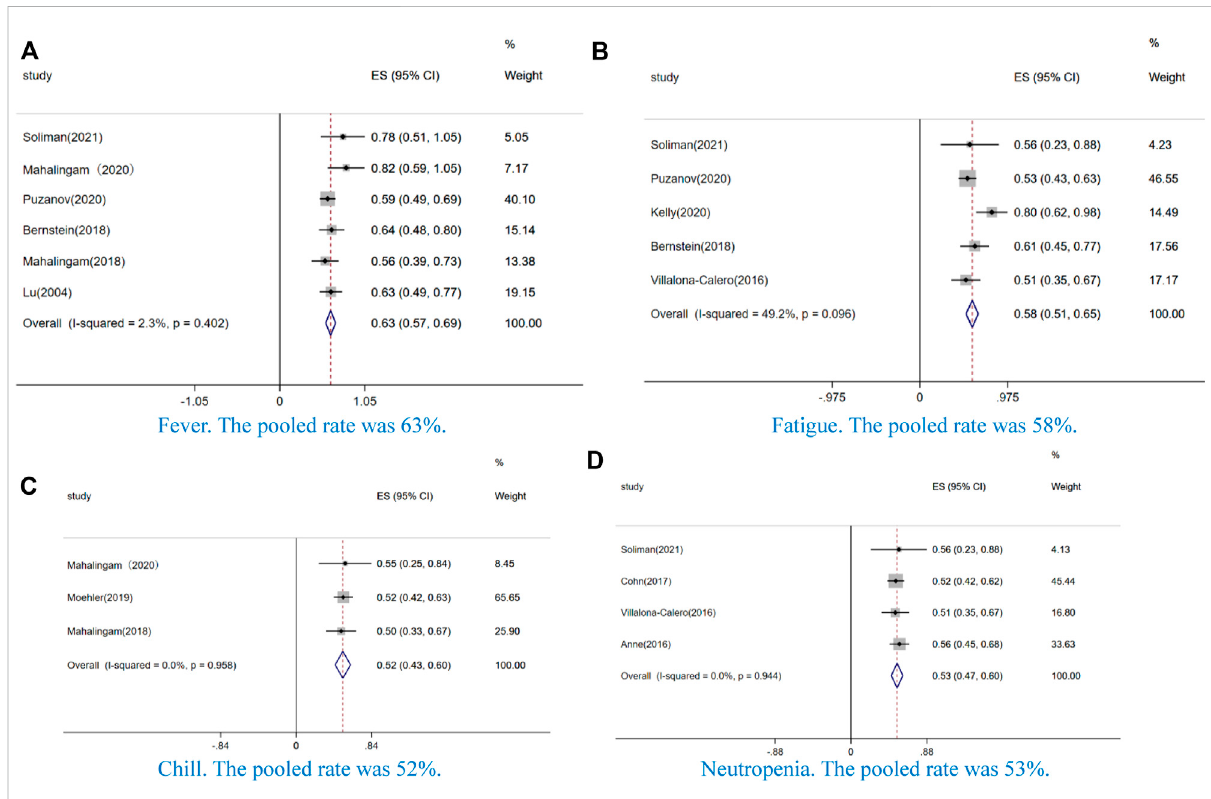
FIGURE 4 Forest plot of the pooled data that AE incidence ≥ 50%, including (A) fever, (B) fatigue, (C) chill, and (D)